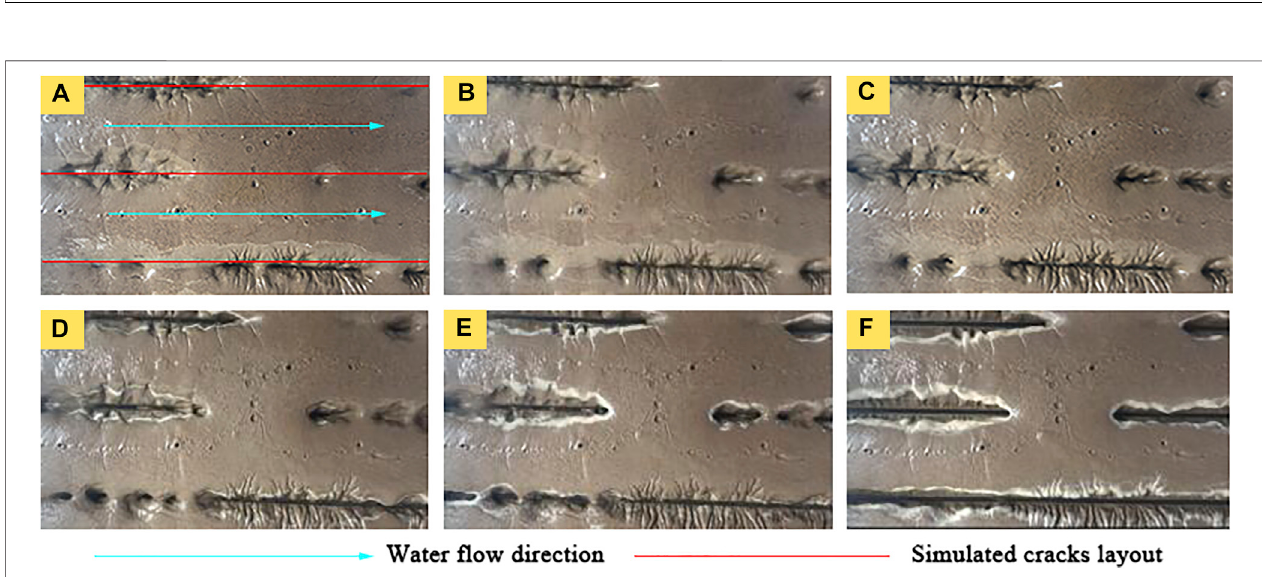
FIGURE4| Surfacecollapseprocessundersanderosion. (A) Afterthe fi rstwaterreserve – dischargecycle; (B) afterthreewaterreserve – dischargecycles; (C) after fi ve water reserve – discharge cycles; (D) after seven water reserve – discharge cycles; (E) after ten water reserve – discharge cycles; and (F) after thirteen water reserve – discharge cycles.